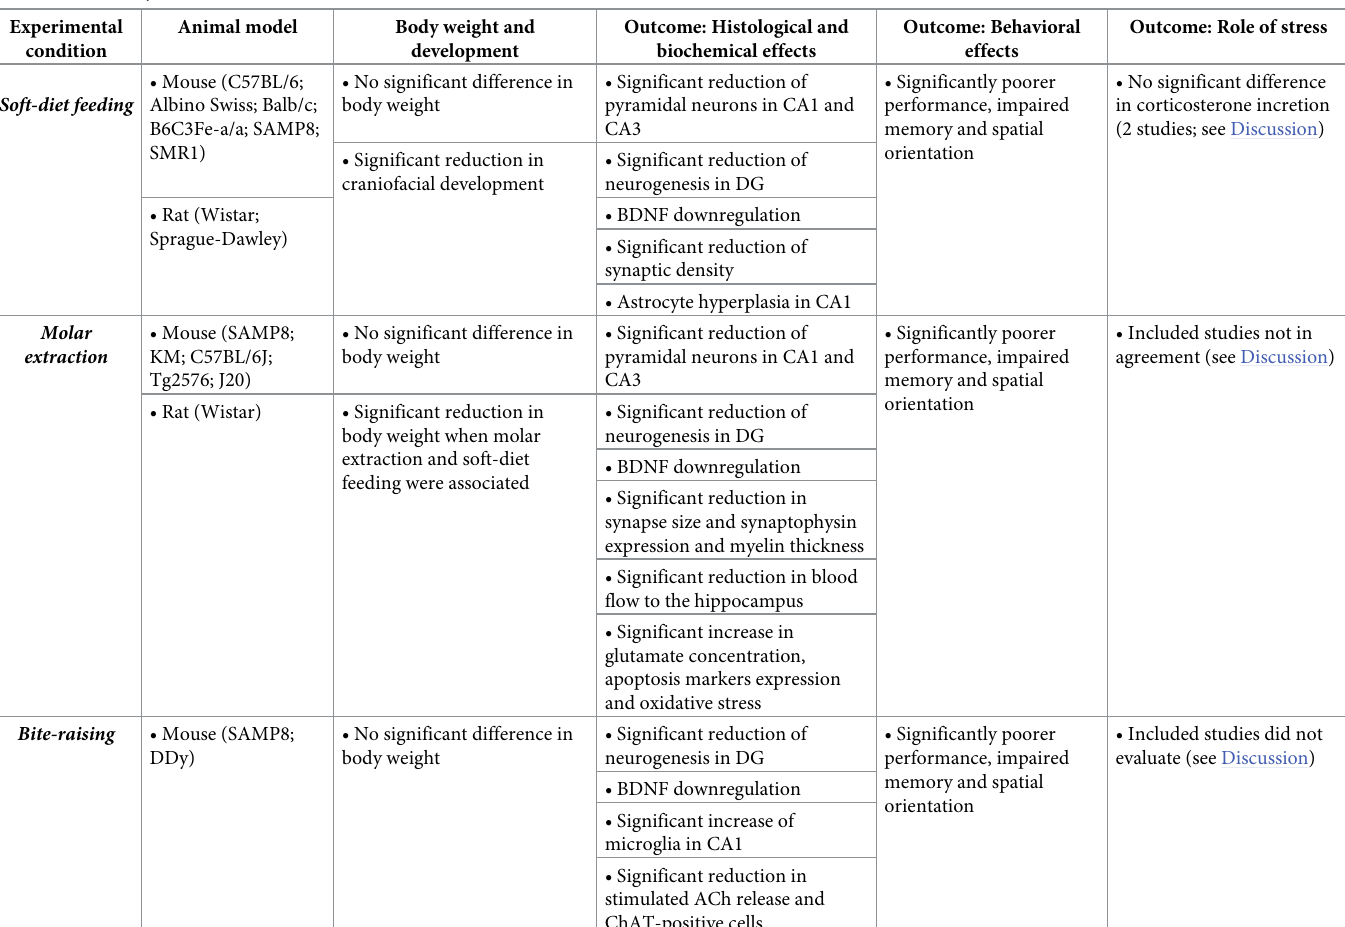
Table 6. Summary of